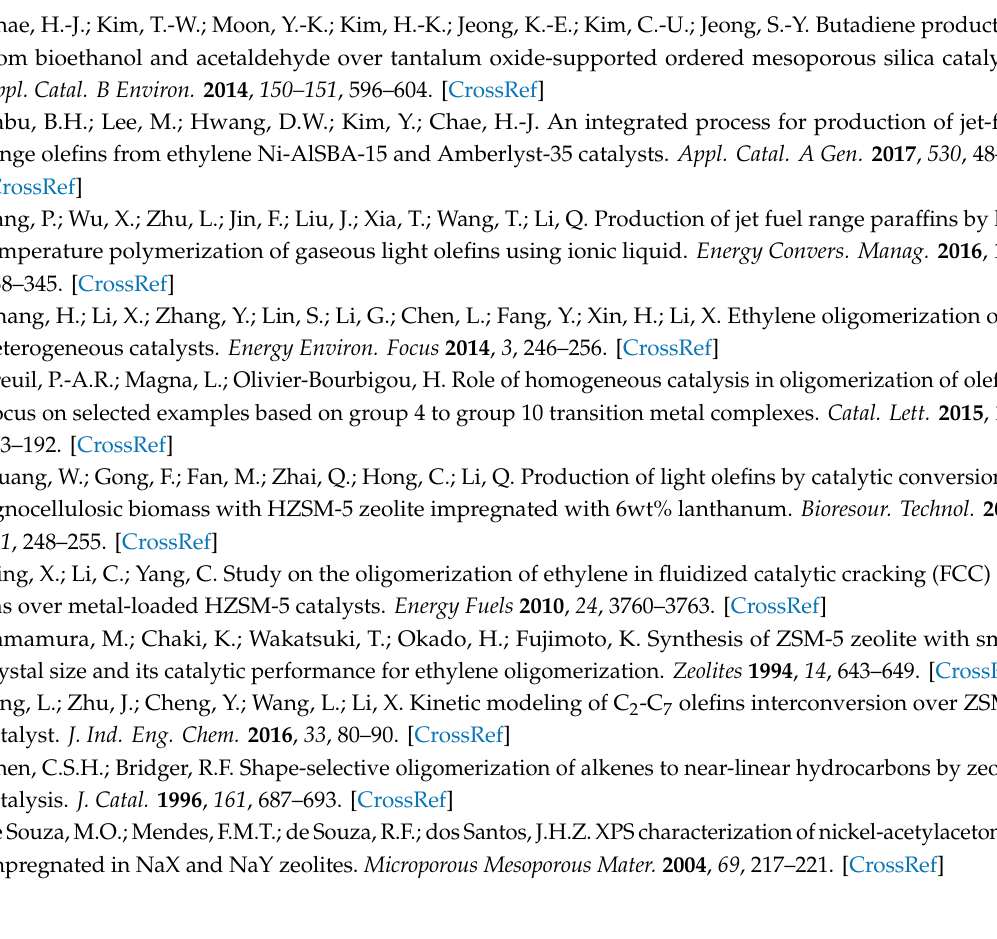
Figure S1: HAADF-TEM images, EDS maps, and EDS spectra of NiOx / SA-001, NiOx / SA-007, NiOx / SA-028, NiOx / SA-047, and NiOx / SA-386, Figure S2: N 2 adsorption–desorption isotherms of NiOx / SA-001, -007, -028, -047, and -386 and pore size distribution curves of the corresponding catalysts calculated using the BJH formalism from the N 2 desorption branch